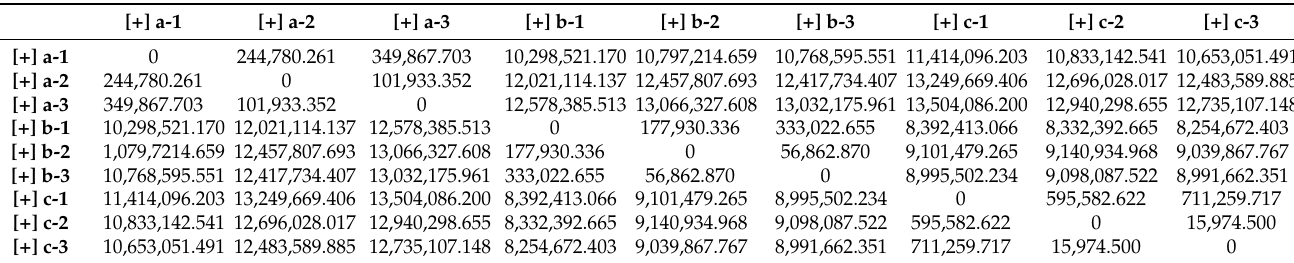
Table 2. Euclidean distances of different